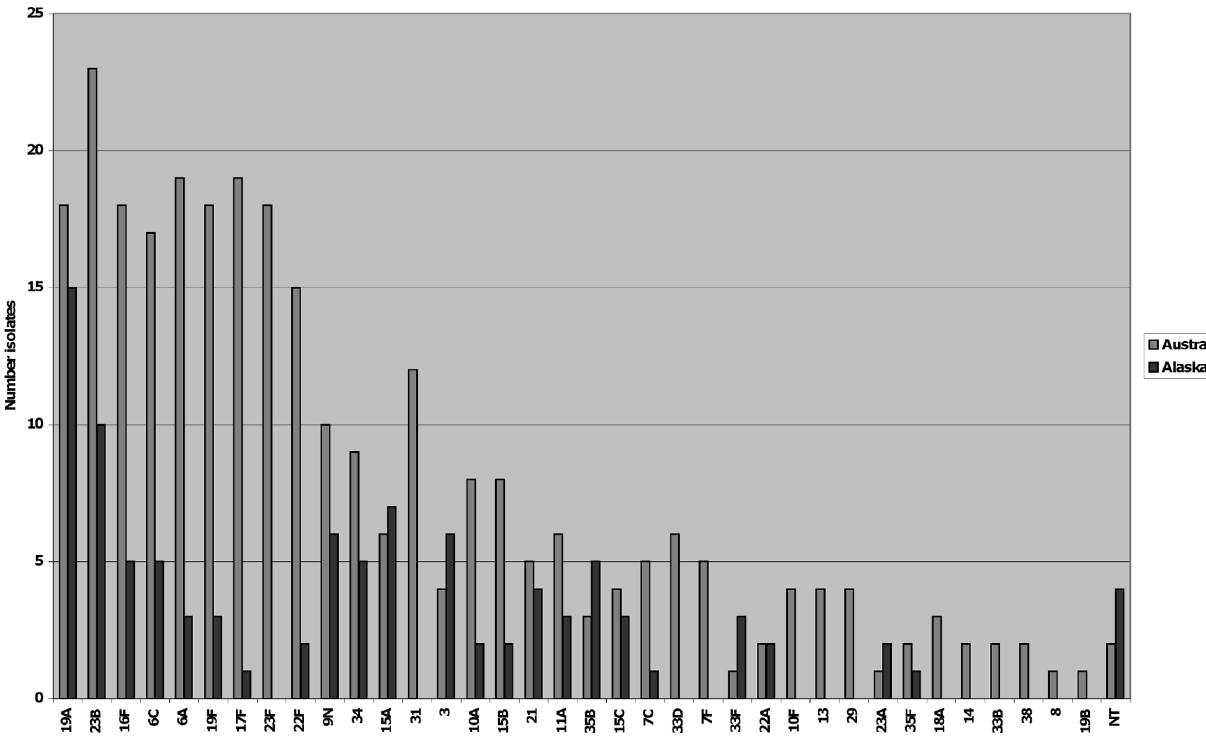
Figure 3. Streptococcuspneumoniae serotype hierarchy (ordered by combined totals) for 79 Australian and 41 Alaskan children. NT, nontypeable.